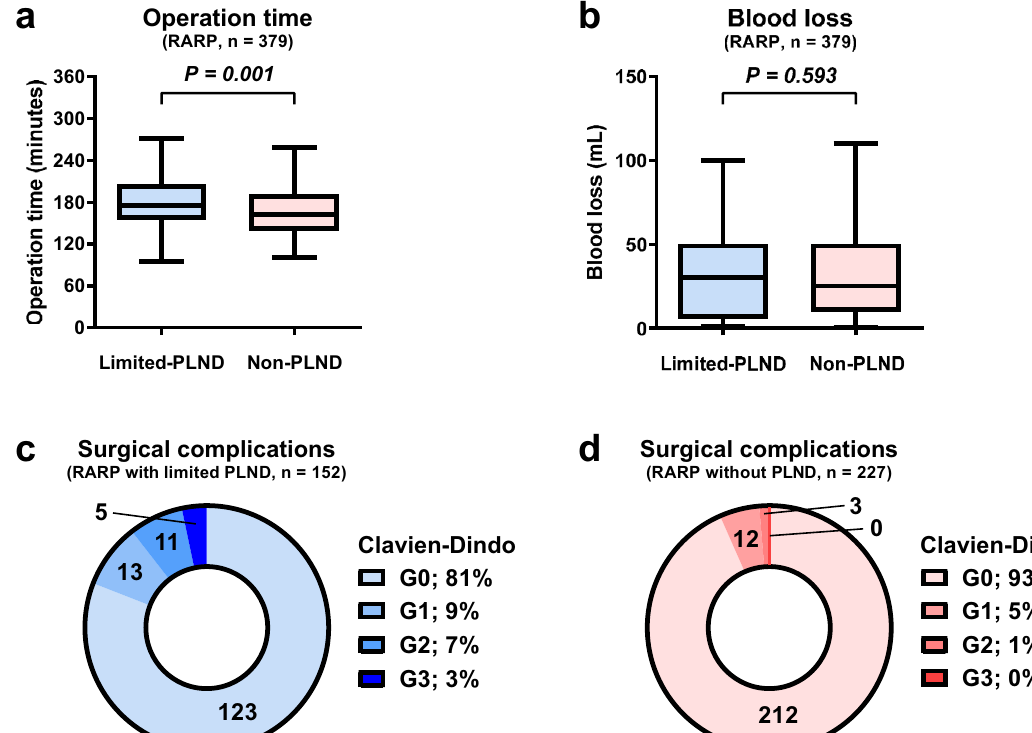
Figure 1. Operation time ( a ), blood loss ( b ), and surgical complications ( c,d ), between the limited-PLND and non-PLND groups (excluding RRP cases). PLND pelvic lymph node dissection, RARP robot-assisted radical prostatectomy, RRP retropubic radical prostatectomy. *Since surgical invasiveness and difficulty greatly differ between RRP and RARP, only RARP cases were included to examine the impact of PLND on surgical